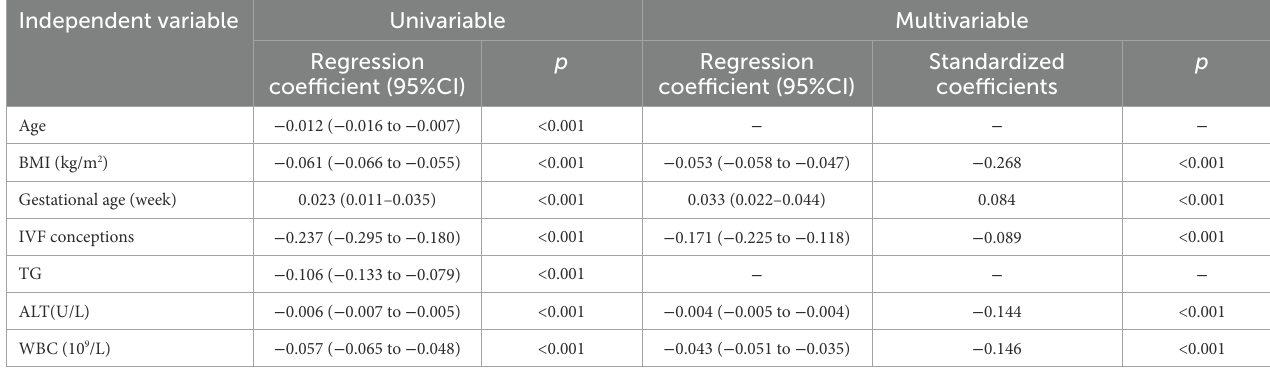
TABLE 2 Regression analysis for predicting √ FF in 4,281 pregnancies with male fetuses.